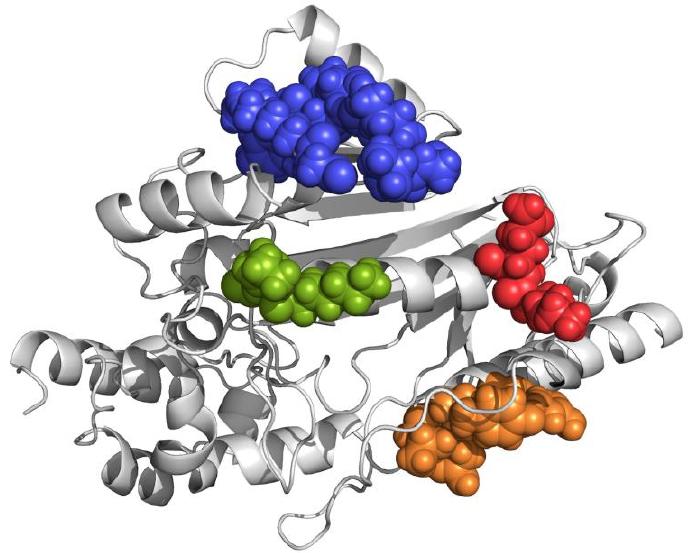
Figure 5. Species-specific epitopes for Rs AK.